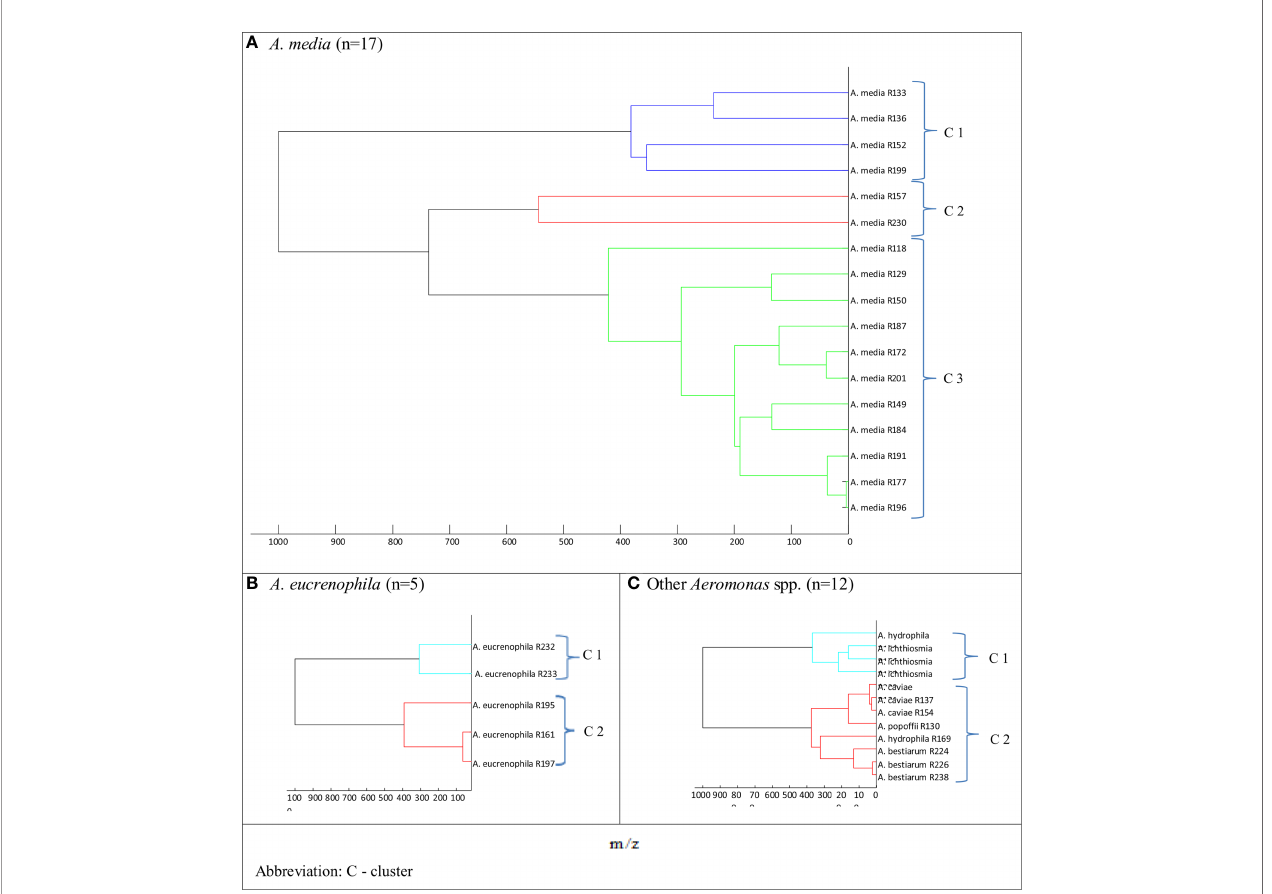
FIGURE 2 | Main spectra pro fi le dendrograms determining the relationship between freshwater reservoir Aeromonas strains: (A) Aeromonas media , (B) Aeromonas eucrenophila , and (C) other Aeromonas spp. generated by MALDI